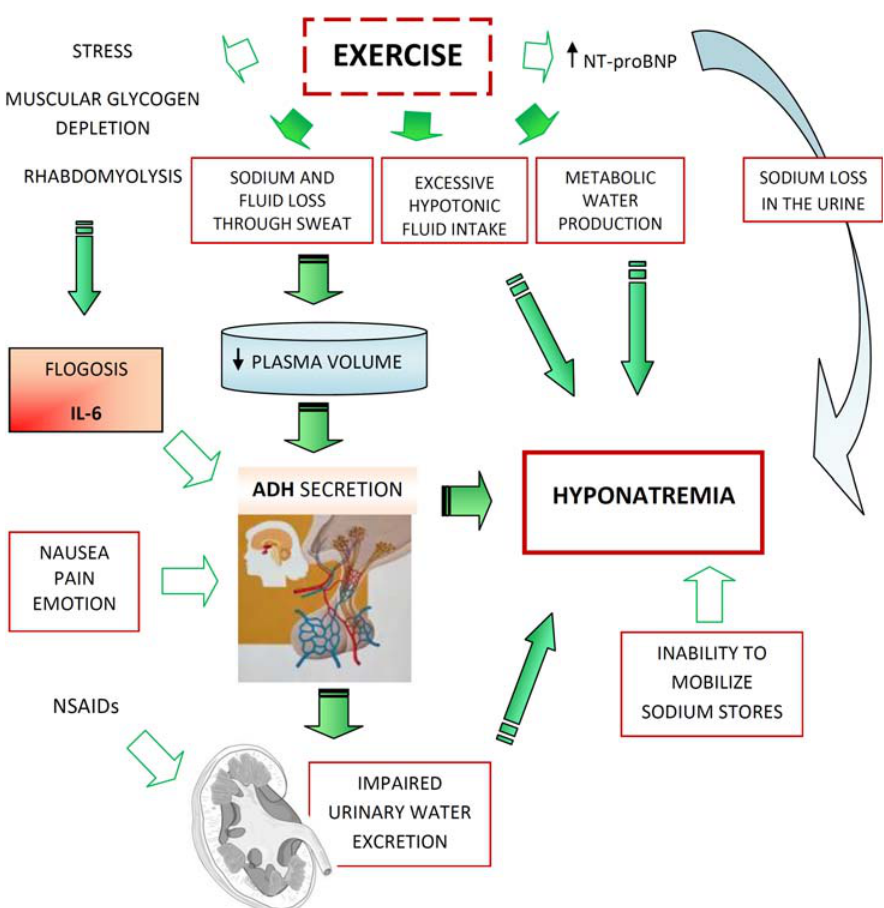
Figure 1. Physiopathology of